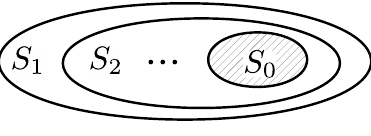
Figure 2. A nested sequence of areas around S 0